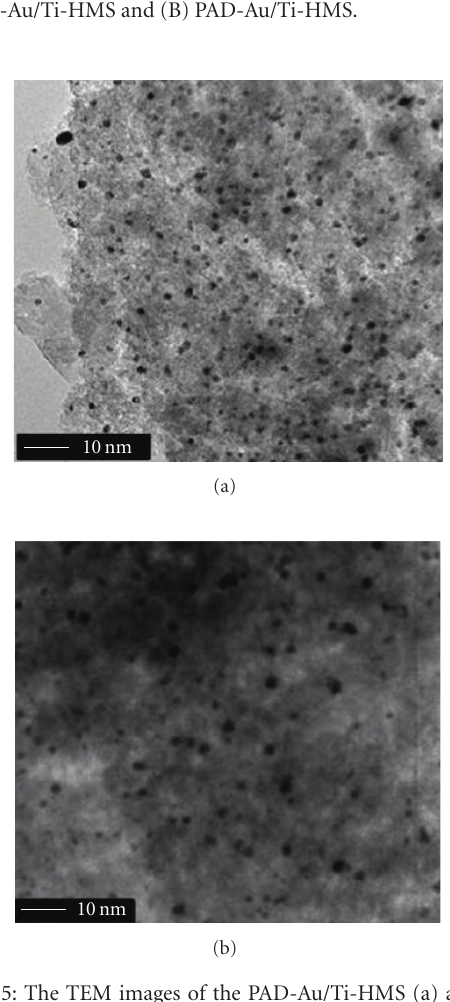
Figure 5: The TEM images of the PAD-Au/Ti-HMS (a) and img- Au/Ti-HMS (b) catalyst after H 2 treatment at 473